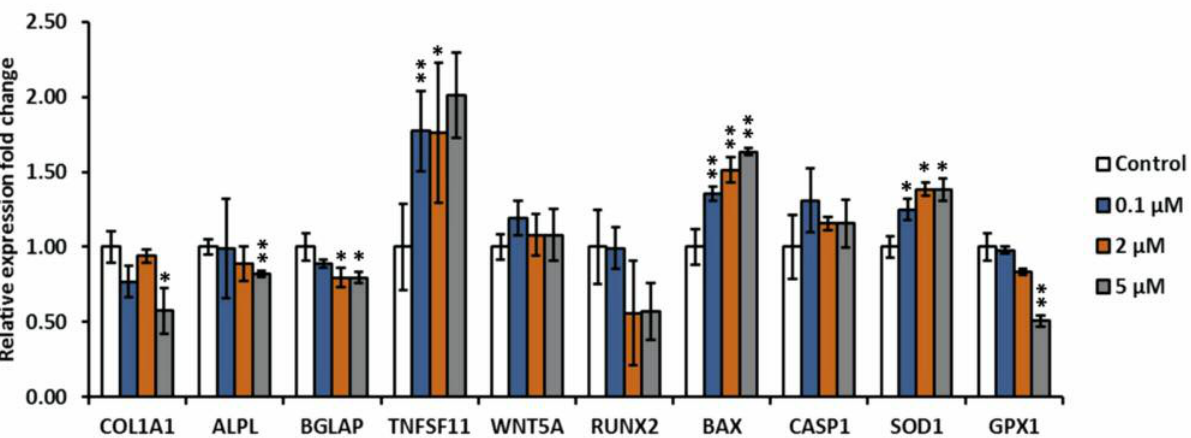
Figure 3. The e ff ect of Cd treatment on gene expression of human osteoblasts. Results are expressed as fold change relative to control and normalized to RPLP0 and ACTB mRNA values. * and ** indicate significant ( p < 0.05 and p < 0.01, respectively) di ff erences compared to control.